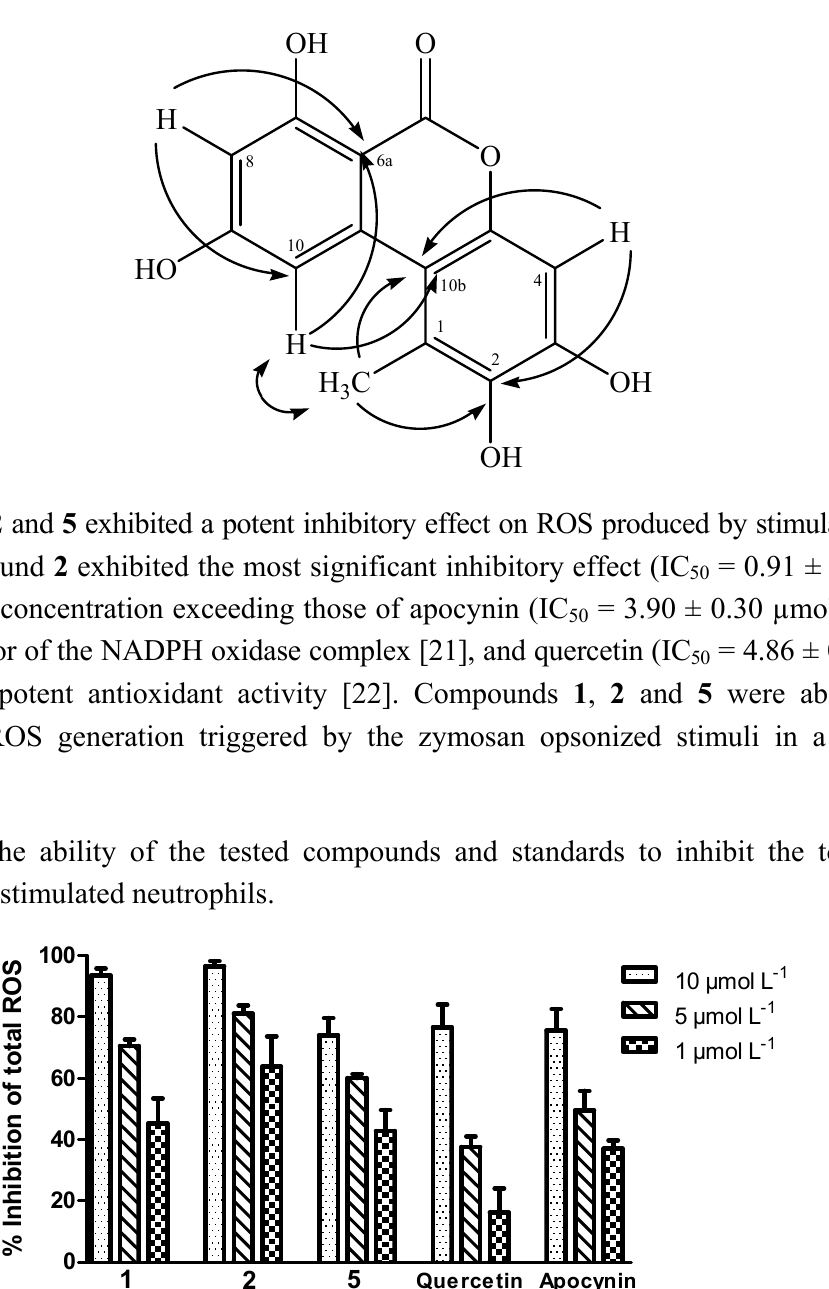
Figure 2. Key HMBC ( → ) and NOESY ( ↔ ) correlations for 2-hydroxy-alternariol ( 7 ).